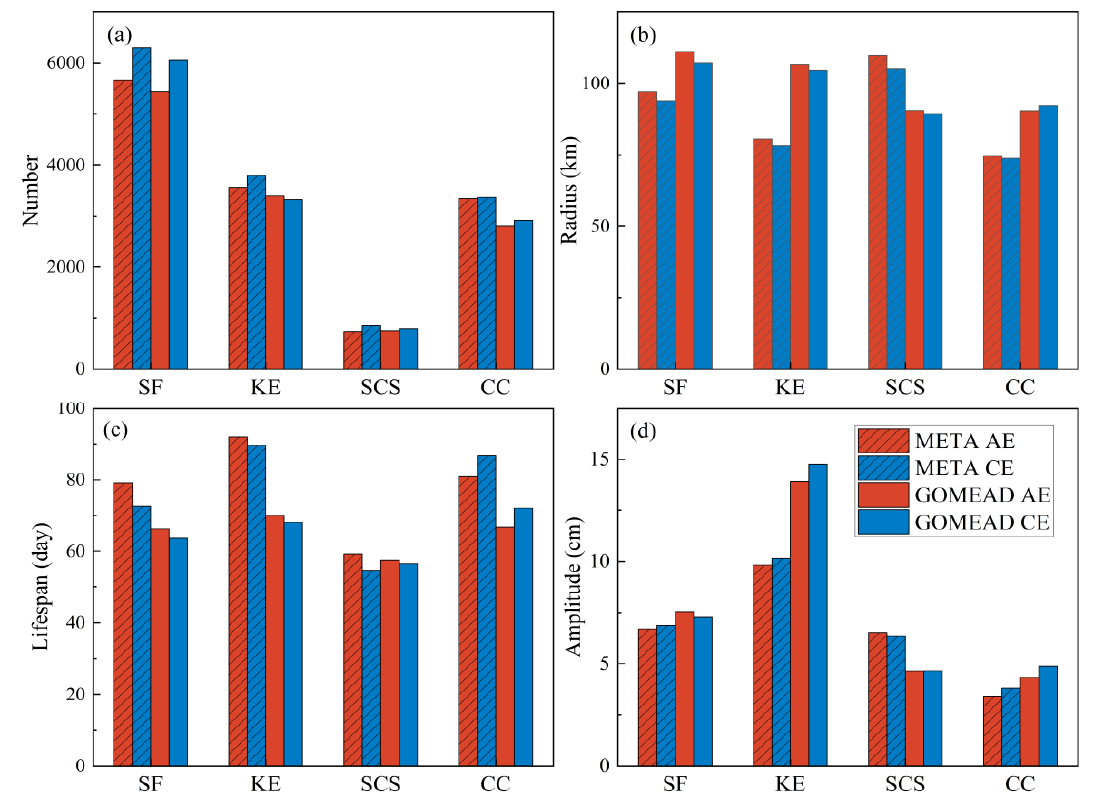
Figure 2. Comparison of eddy number ( a ), radius ( b ), lifespan ( c ) and Amplitude ( d ) in four regions.